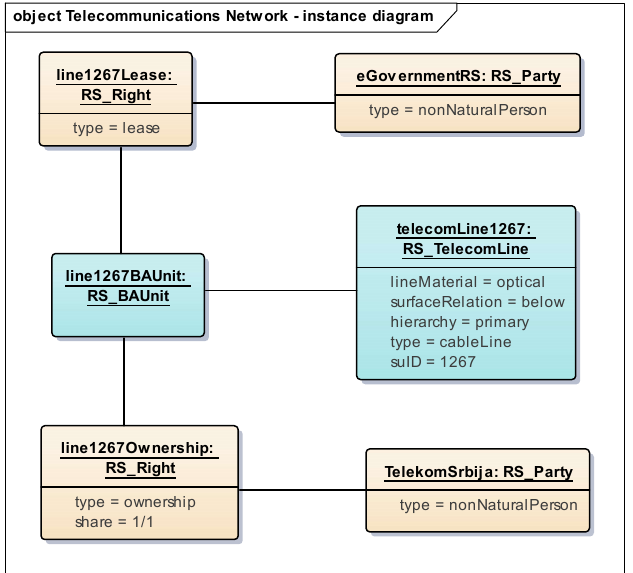
Figure 7. Instance diagram showing the lease on optical cable lines.